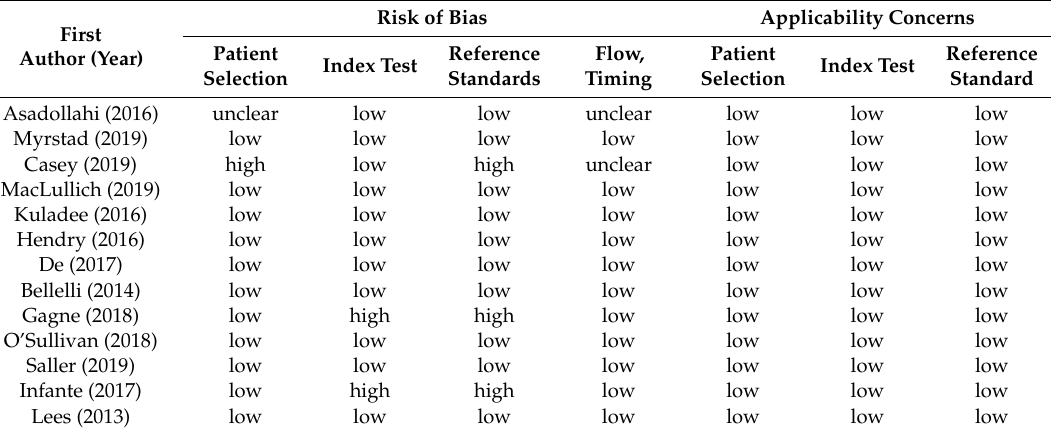
Table 2. Results of risk of bias assessment of the included